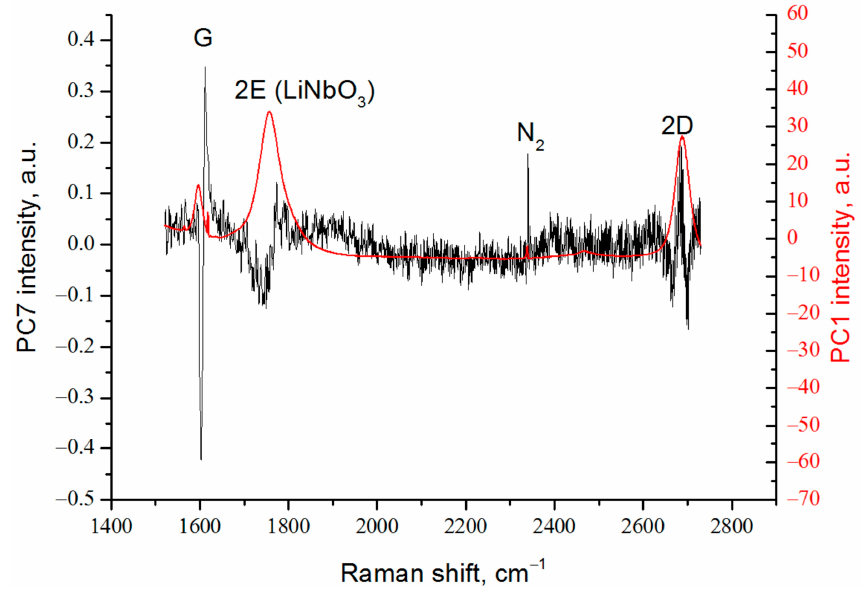
Figure 6. Comparison of load vectors PC1 and PC7.